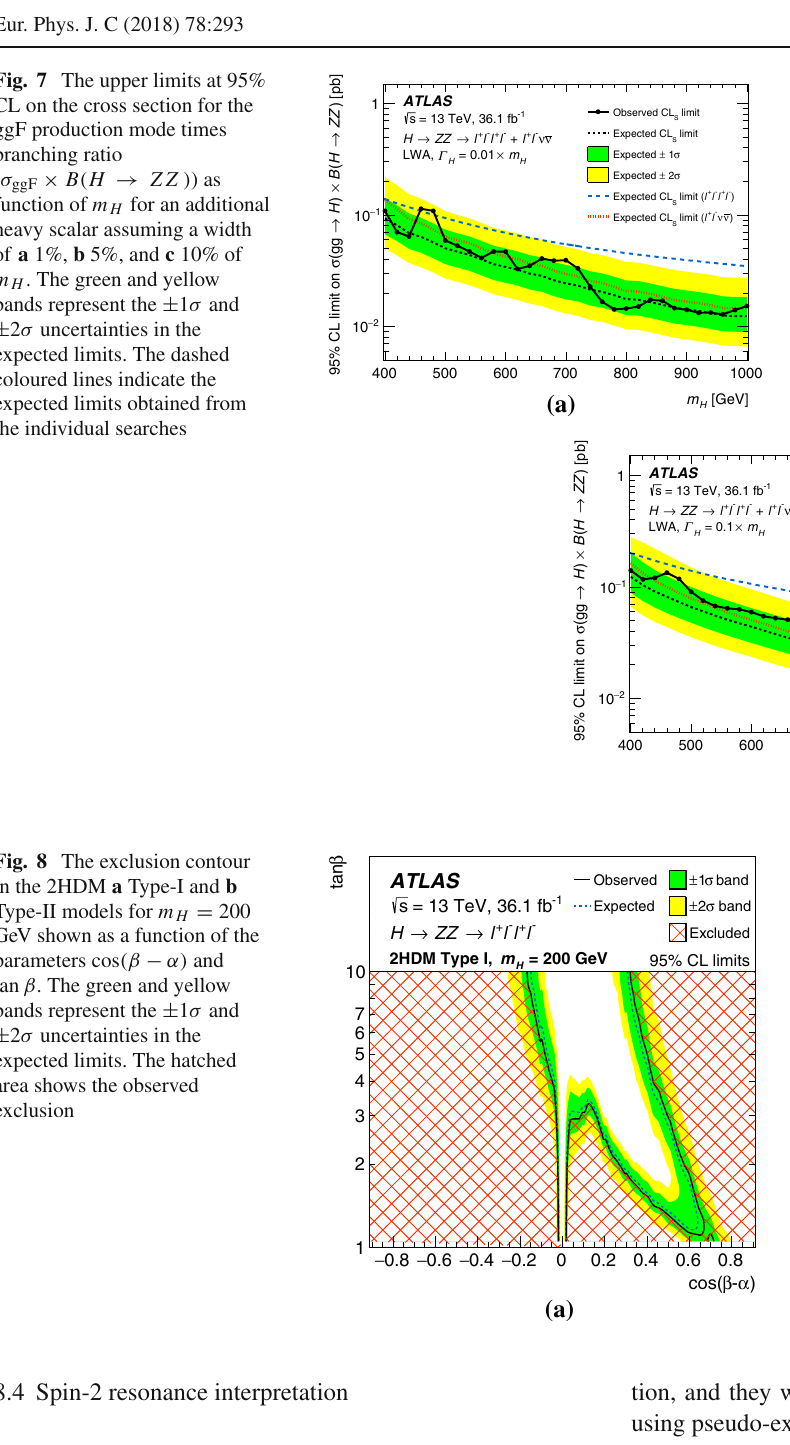
Fig. 7 The upper limits at 95% CL on the cross section for the ggF production mode times branching ratio ( σ ggF × B ( H → Z Z ) ) as function of m H for an additional heavy scalar assuming a width of a 1%, b 5%, and c 10% of m H . The green and yellow bands represent the ± 1 σ and ± 2 σ uncertainties in the expected limits. The dashed coloured lines indicate the expected limits obtained from the individual searches